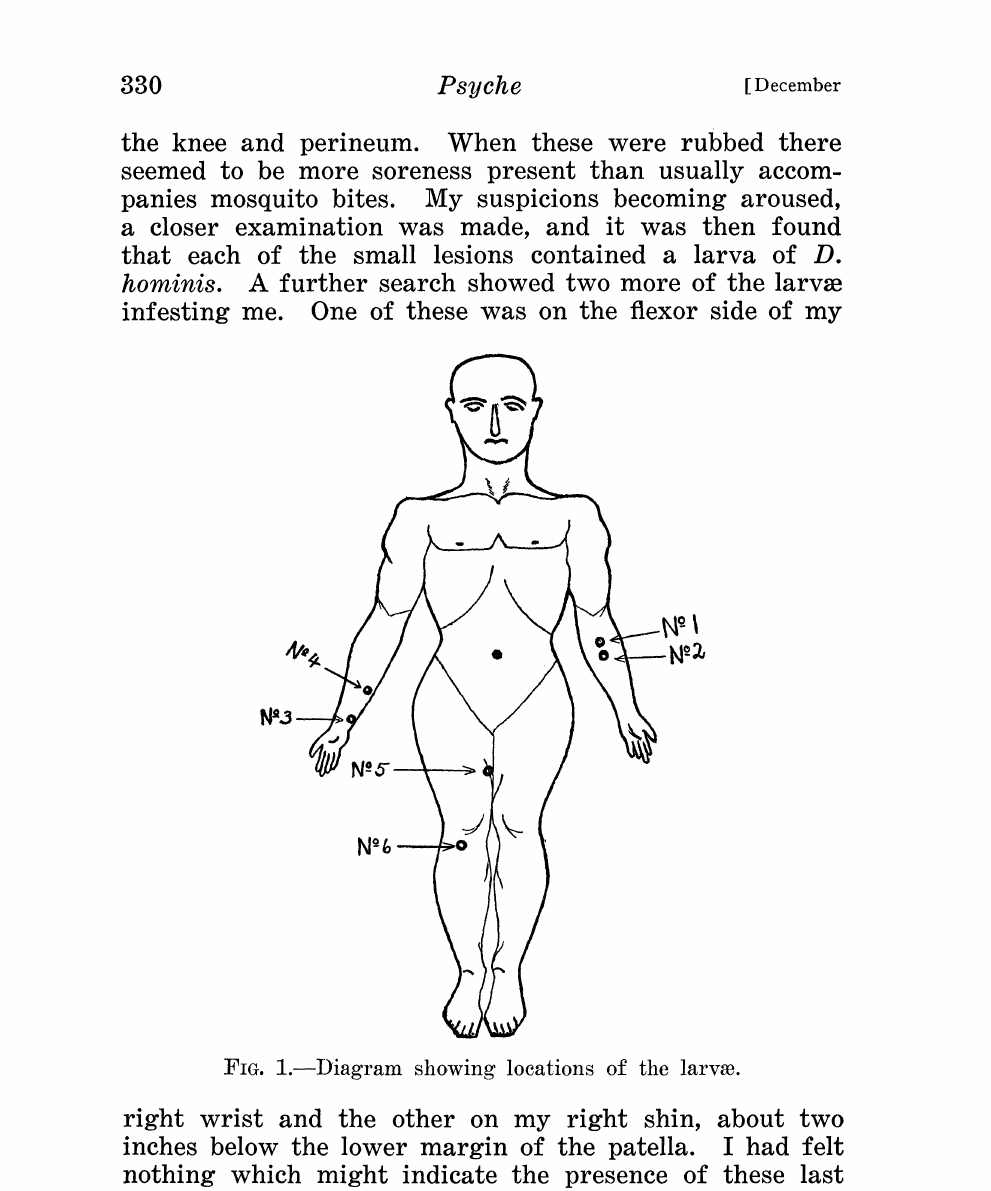
FIG. 1.--Diagram showing locations of the